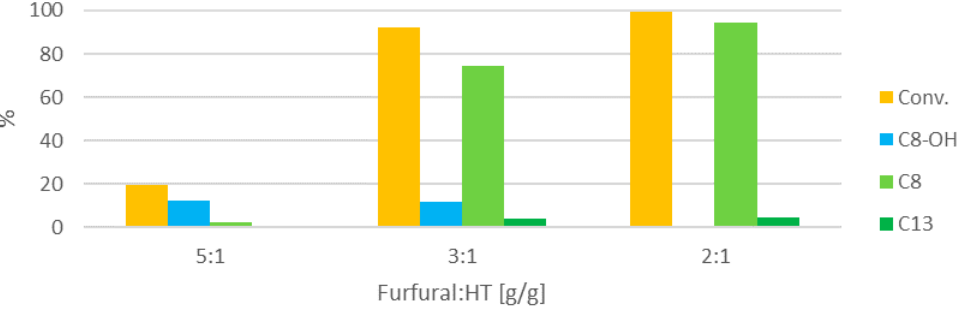
Figure 6. Influence of the furfural:HT ratio (at 100 °C, 30 min, concentration 0.21 M).